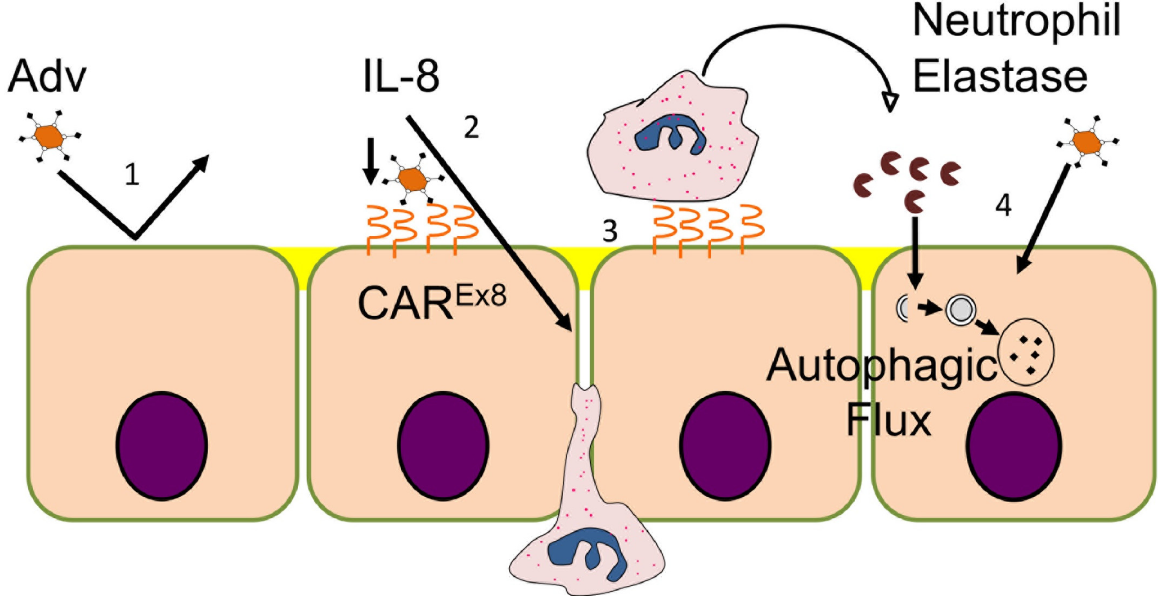
Figure 7. Summary model of how innate immune factors regulate epithelial susceptibility to AdV5 infection. (1) Under normal circumstances, polarized epithelia express very low levels of apical CAR Ex8 , making them relatively resistant to apical AdV infection. (2) AdV-5 triggers release of proinflammatory cytokine IL-8, which induces apical expression of CAR Ex8 and (3) transepithelial migration of neutrophils. (4) Once neutrophils arrive, release of HNE further enhances AdV-5 transduction of epithelia through a process that involves activation of epithelial autophagic